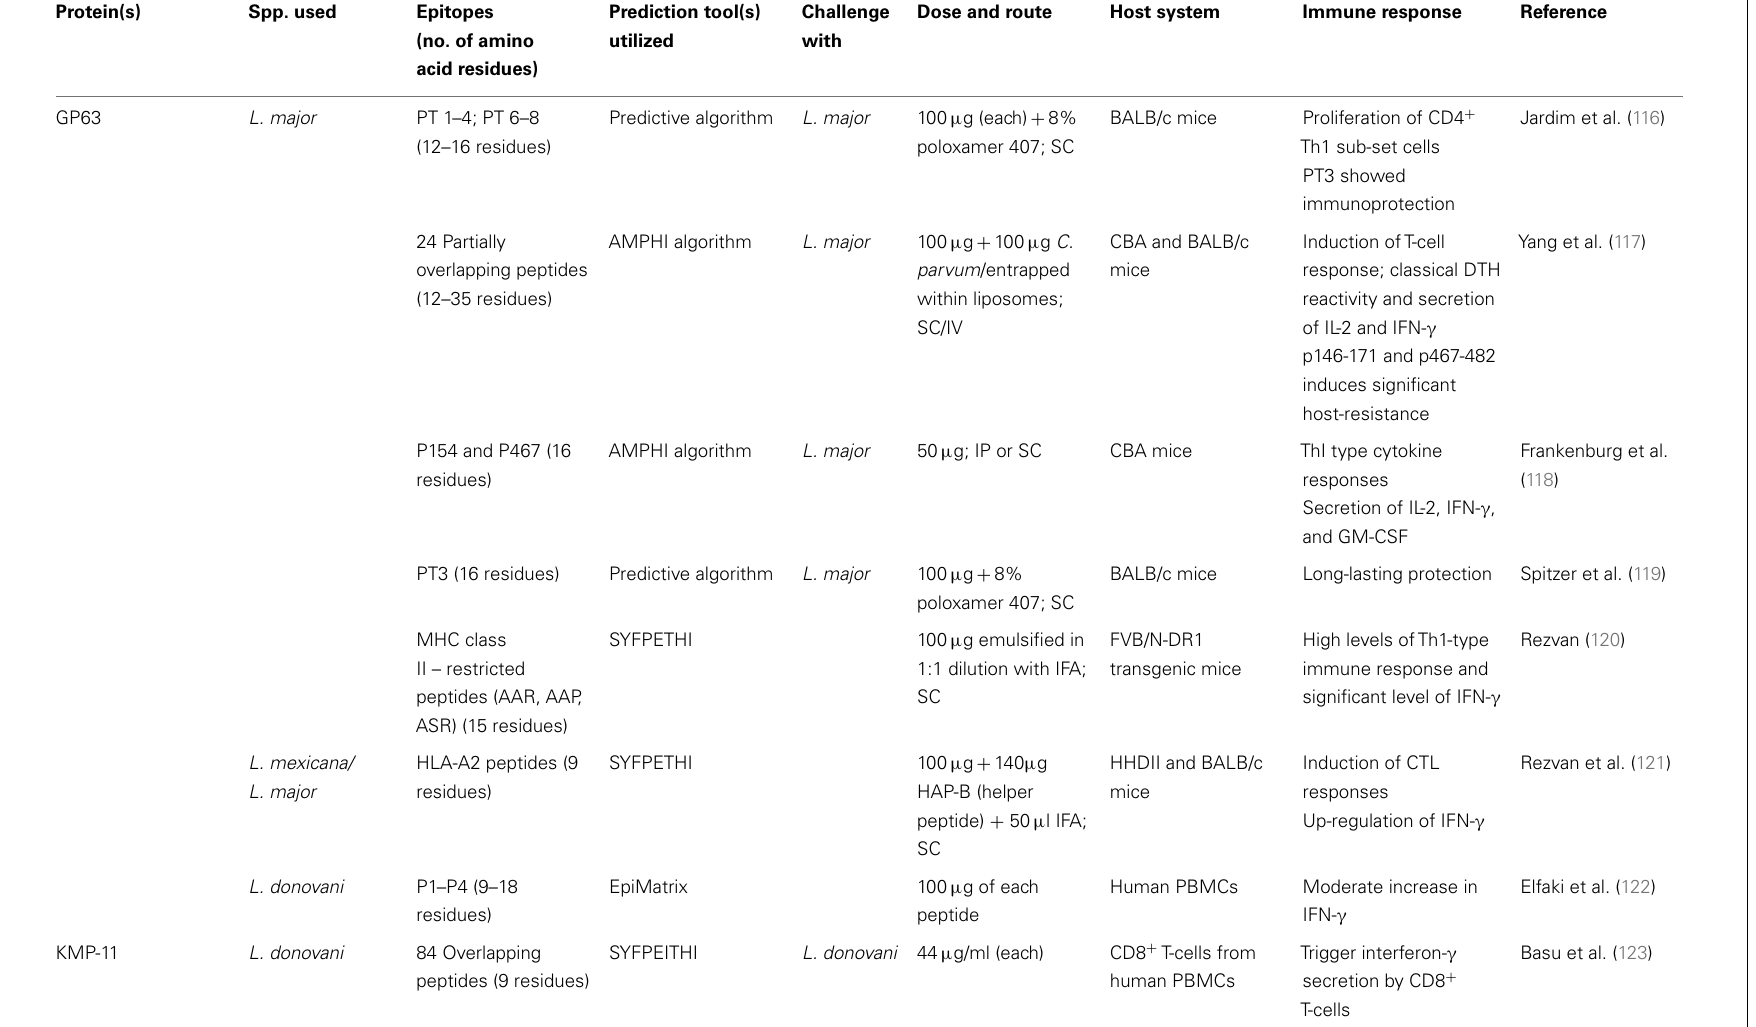
Table 2 | Summary of peptide vaccines evaluated against leishmaniasis .